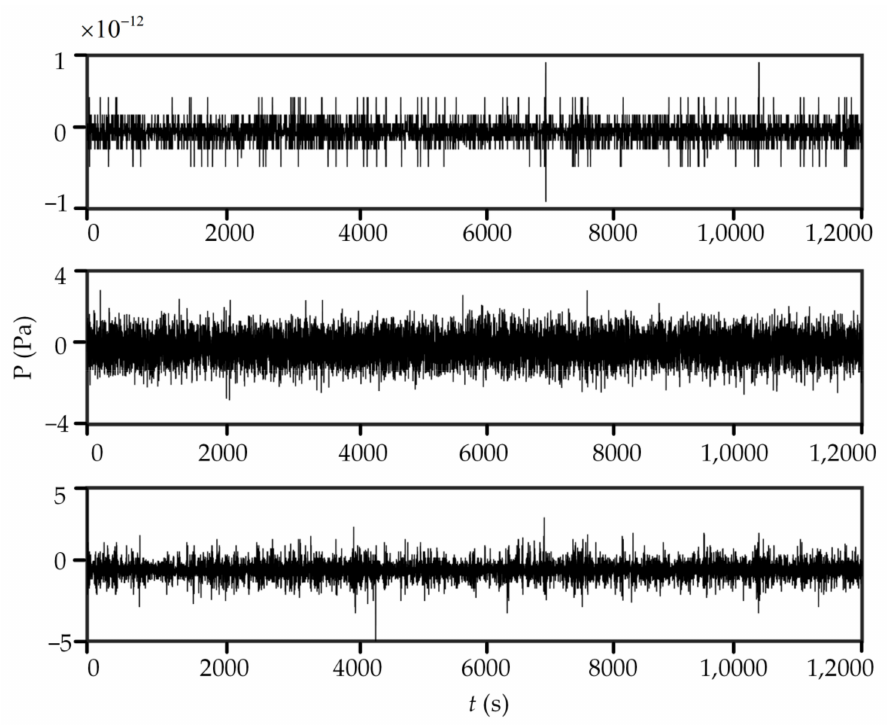
Figure 8. The reconstruction error of EMD, EEMD and CEEMD from top to